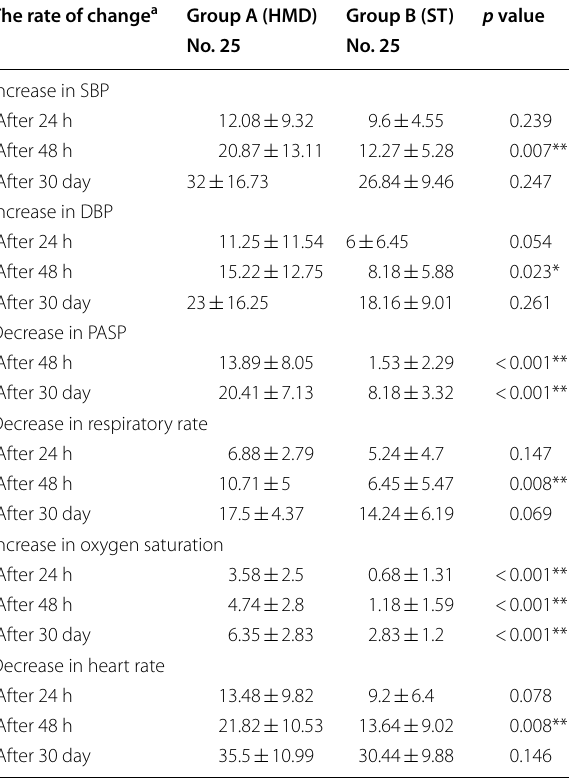
Table 3 Rate of change in efficacy parameters of the study groups subtracting the previous value from the follow‑up